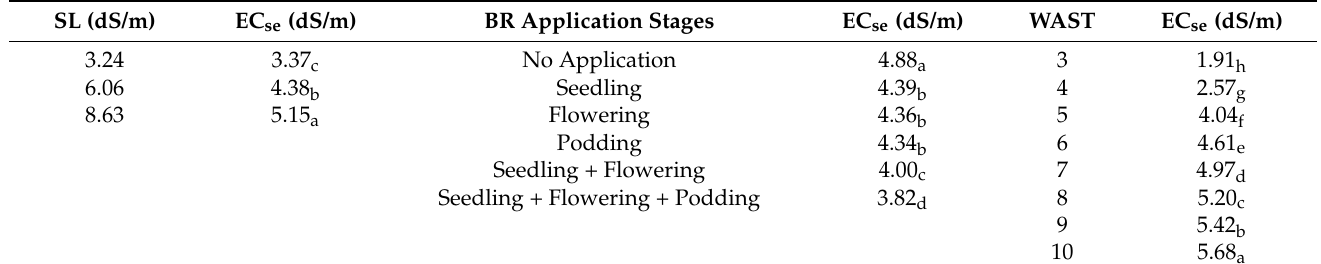
Table 2. Main effects of salinity levels (SLs), growth stages of application of 24-epibrassinolide (BR) and weeks after commencement of irrigation with saline water (WAST) on electrical conductivity of saturated soil extracts (EC se s, dS/m) in soybean